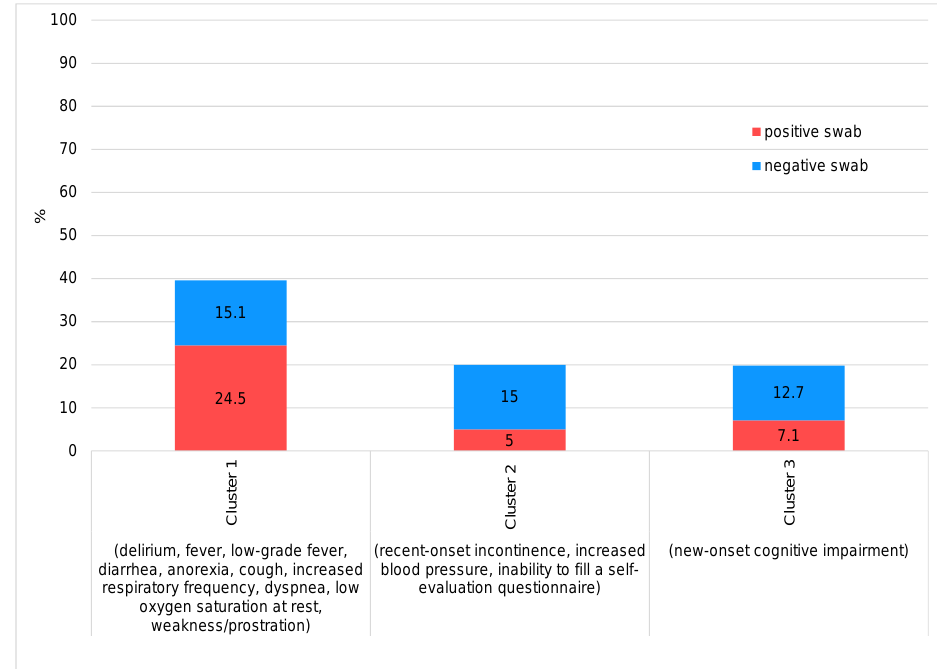
Figure 3. Participants (%) in each cluster and SARS-CoV-2 swab test results. Residents were observed for a median time of 61 days, and those with positive swab test had a median duration of RT-PCR positivity for 20 days. At the end of the observation period, 71.4% of SARS-CoV-2-positive residents who had only one symptom and 47% of